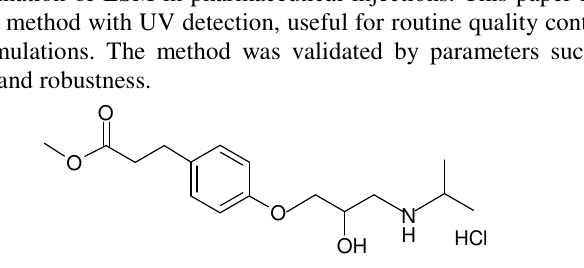
Figure 1. Structure of esmolol